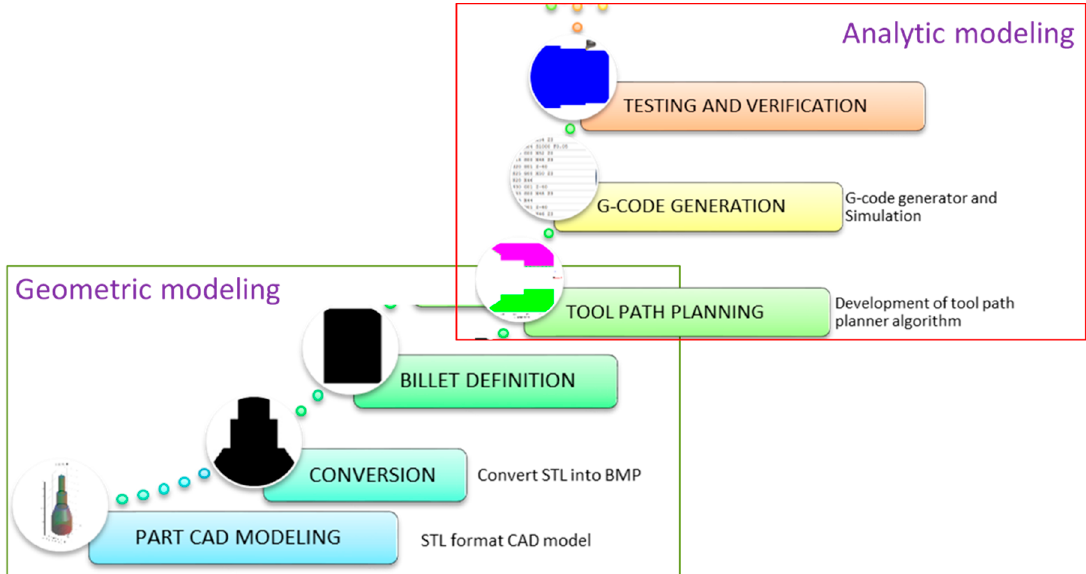
Figure 1. Diagram of research design and workflow. In this workflow, a geometric model was imported into a simulation environment and processed into numerical values.